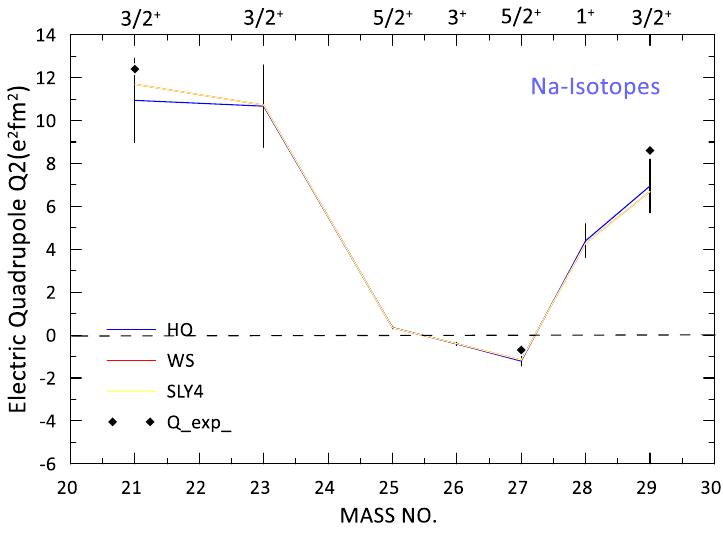
Figure 8: The calculated electric quadrupole moments Q2 (e 2 fm 2 ) for Na-isotopes using different single-particle potentials compared to the experimental data of Refs. [16,